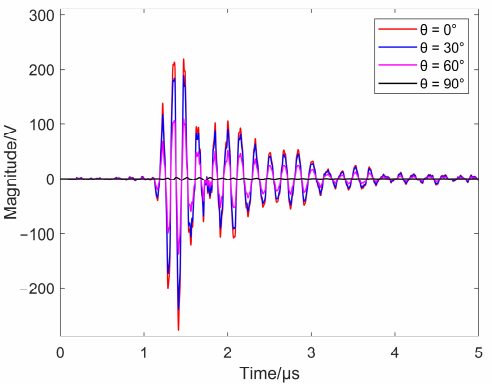
Figure 12. The influence of the direction of the secondary cable wiring on the radiation disturbance. When the included angle changes from 0° to 90°, the radiated disturbance